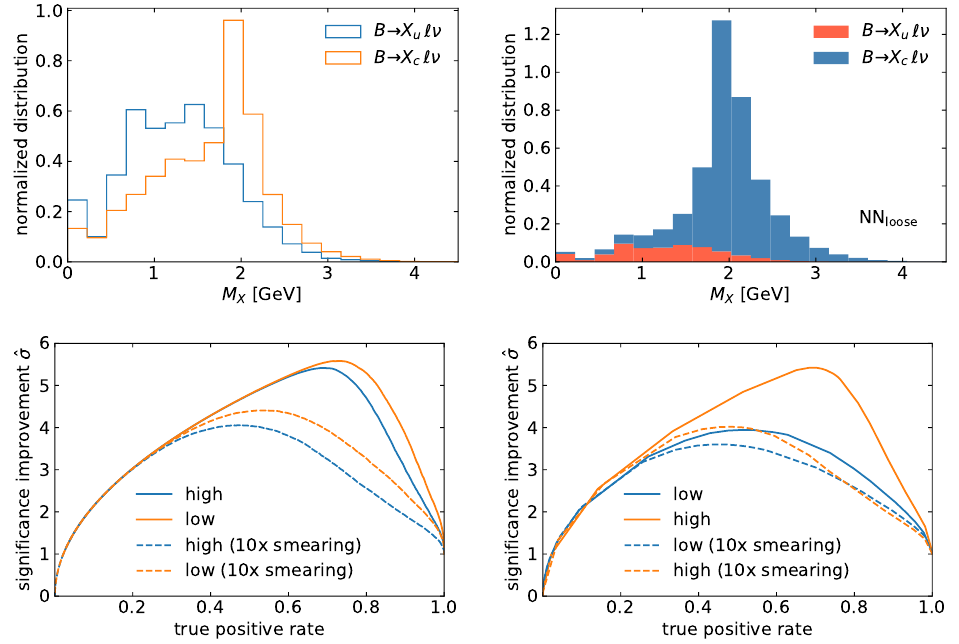
Figure 11 . Top: M X distribution before (left) and after (right) the background suppression BDT (plot analogous to figure 6 in ref. [7]). Bottom: significance improvement for a NN (left) and BDT (right) trained on high-level or low-level input features. We compare our standard set-up to training and testing on a sample with the detector resolution for photons and charged particles broadened by a factor